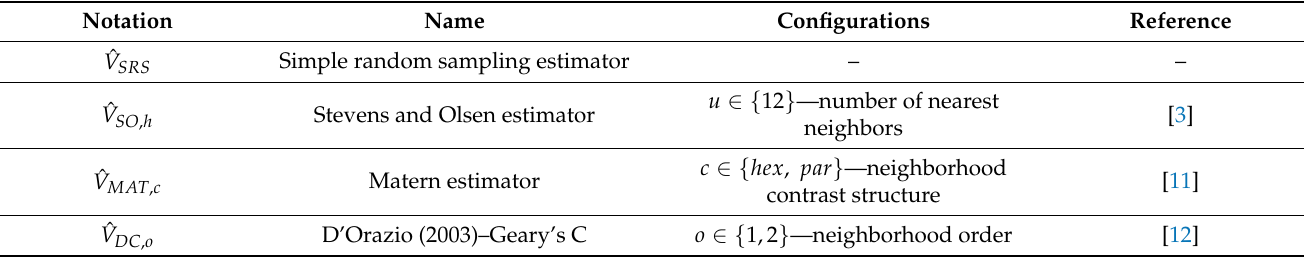
Table 2. Notation, name, and configurations of the variance estimators used in this study. A canonical study that uses the estimator is included if